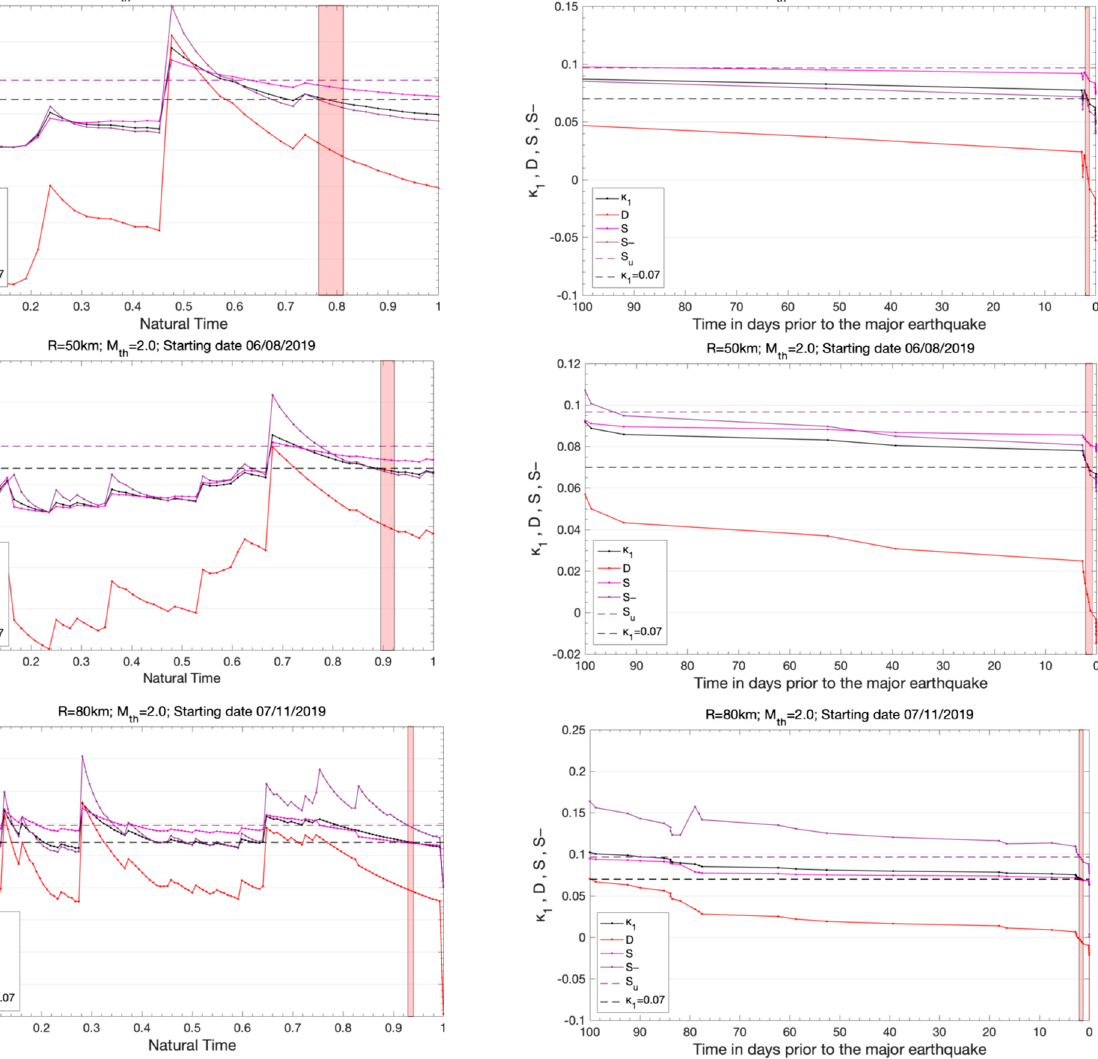
Figure 8. Time evolution of the NT analysis parameters κ 1 , D , S nt and S nt − , in natural time ( left ) and conventional time ( right ), as they evolve event by event prior to the Thessaly M w 6.3 mainshock, considering an area with radius of R = 30 km ( top ), R = 50 km ( middle ), and R = 80 km ( bottom ) around the epicenter and for a magnitude threshold M th = 2.0. The analysis was started on 6 August 2019 for R = 30 km and R = 50 km and on 7 November 2019 for R = 80 km. The dashed horizontal lines indicate the entropy limit of S u = 0.0966 and the value κ 1 = 0.070. The shaded rectangle marks the time when the critical stage is